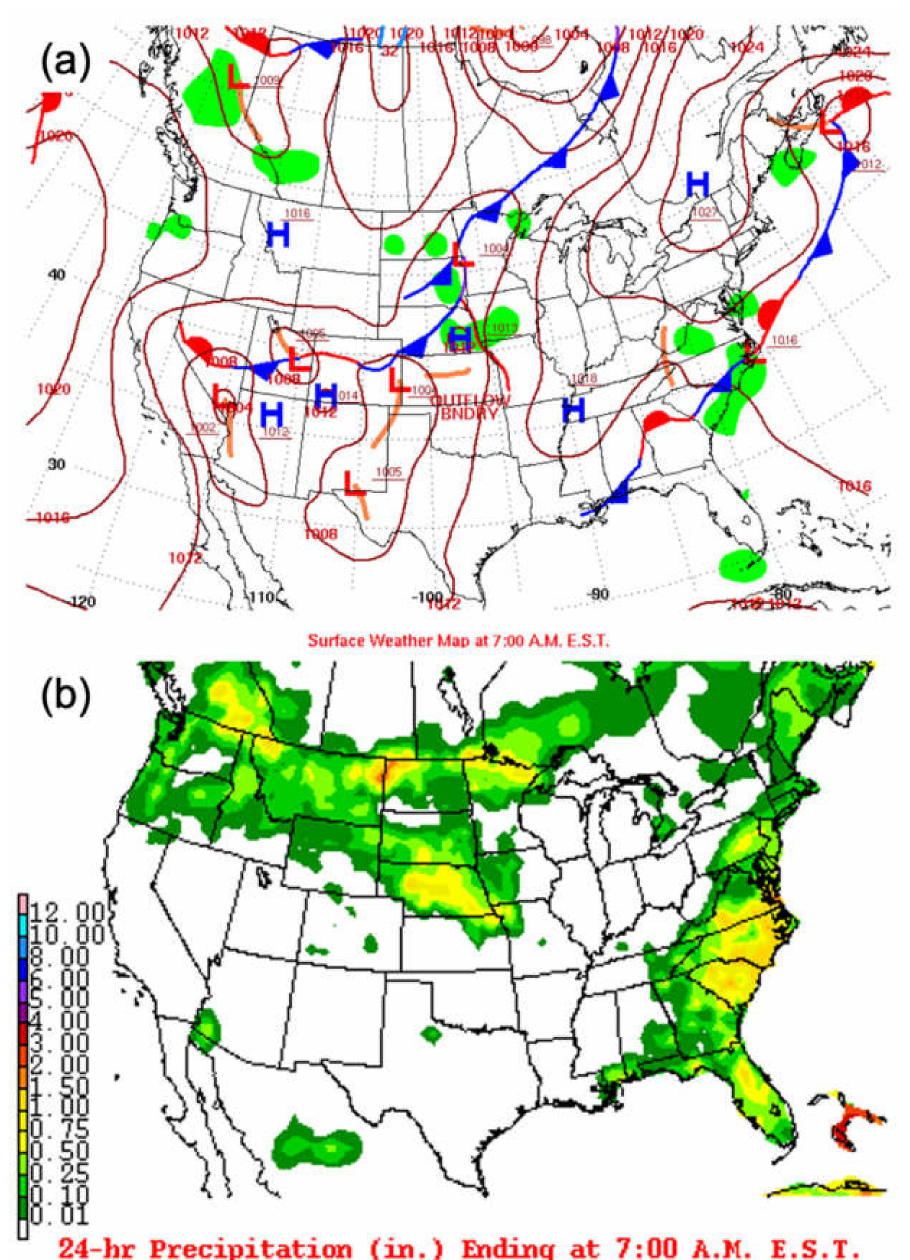
Figure 2. ( a ) Surface weather map at 7:00 AM EST (11:00 UTC) on 3 June 2015, with low-pressure systems and high-pressure systems indicated by L (red) and H (blue), respectively. ( b ) Map showing 24 h precipitation at 7:00 AM EST on 4 June 2015 (http://www.wpc.ncep.noaa.gov/dailywxmap/, accessed on 10 September